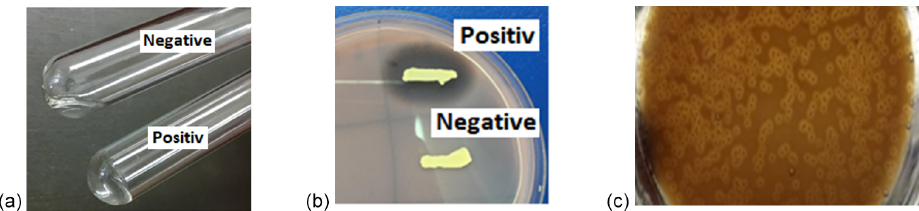
Figure 1. Tests for identification of S. aureus from subclinical bovine mastitis milk sample. (a) Tube coagulase test, (b) deoxyribonuclease test, and (c) haemolytic activity. Table 3. Results of testing antibiotic resistance of S. aureus strains.